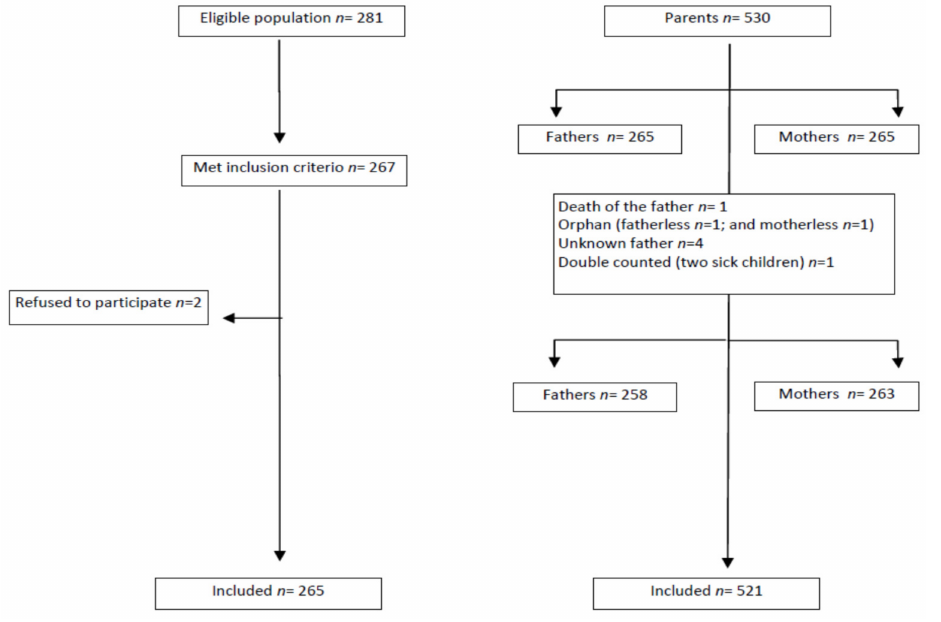
Figure 1. Participants